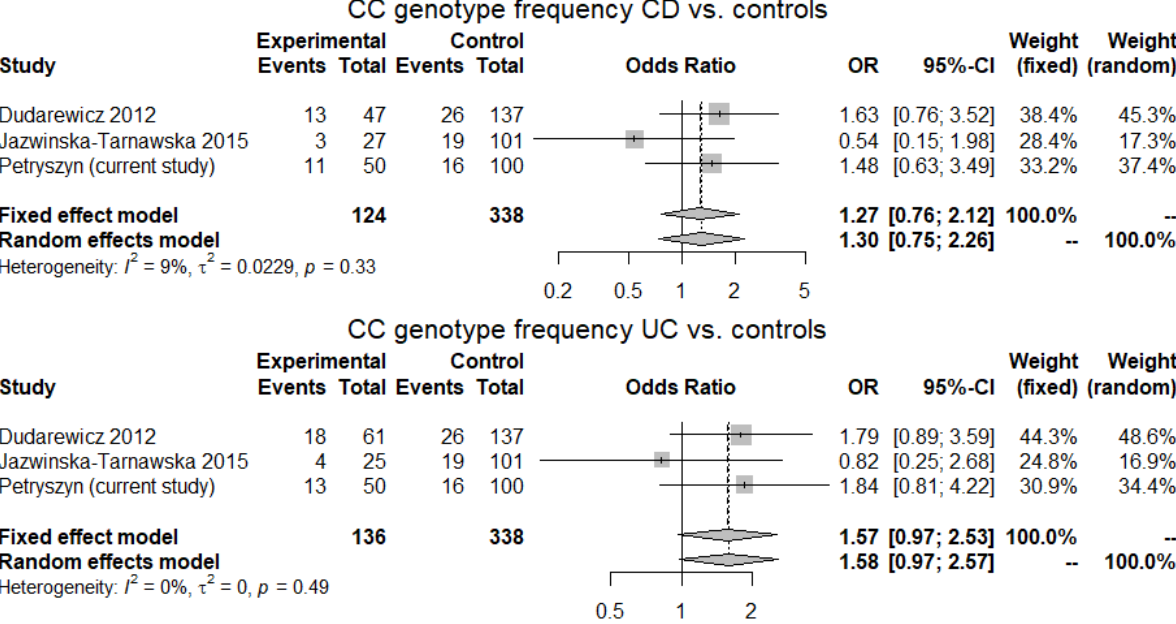
Figure 1. C allele frequency in CD and UC patients vs. controls. Three studies examining an association of C3435T polymorphism of ABCB1 gene with IBD in the Polish population with a total of 124 CD cases, 136 UC cases and 338 controls were included. Heterogeneity was low at I 2 = 0% ( p > 0.05). A study-specific OR was >1 for the C3435 allele both for CD and UC in all of the three studies; however, pooled ORs calculated for fixed- and random-effects models were not significant.